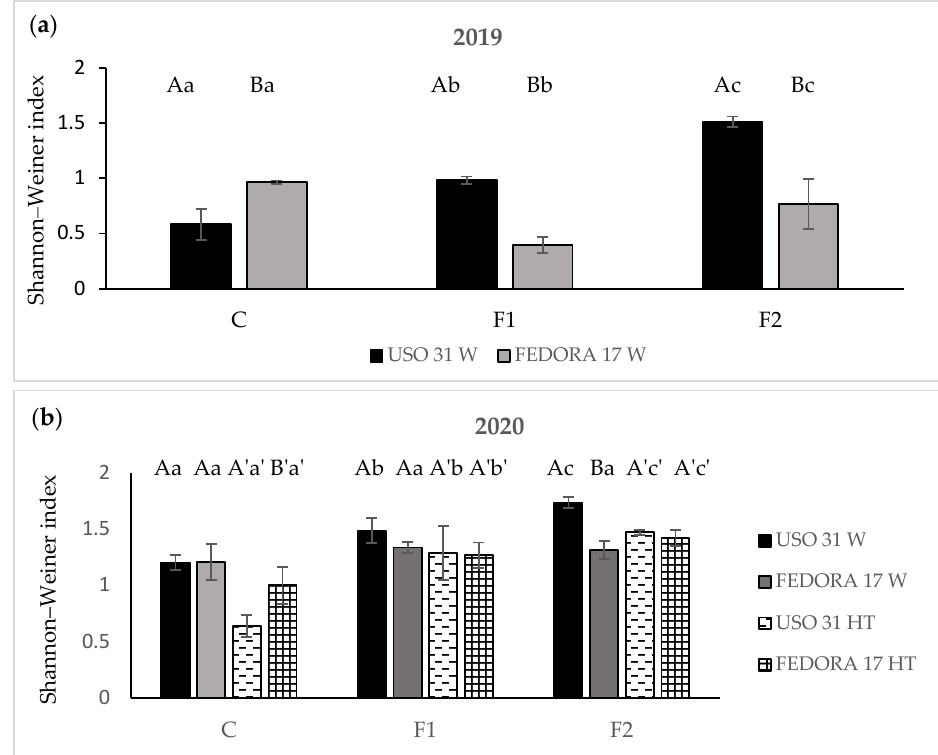
Figure 3. Shannon–Weiner index of weeds in hemp crop during the growing season 2019 ( a ) and during the growing season 2020 ( b ). Vertical bars indicate the standard errors of the means. Values without a common le tt er are statistically signi fi cant according to LSD (0.05).